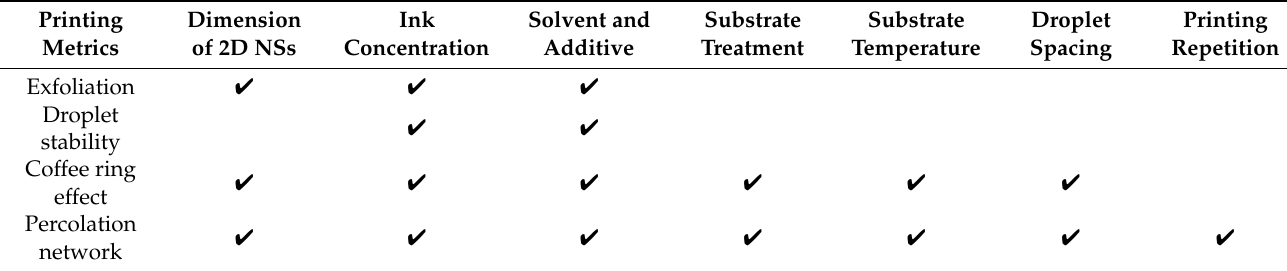
Table 3. Factors for 2D material printing performance and their correlation with each